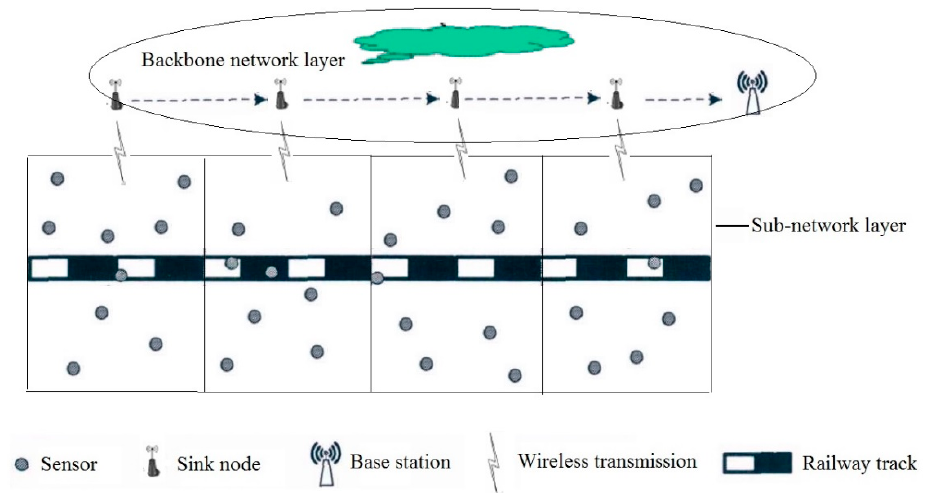
Figure 1. Architecture of double-layer wireless sensor network for railway status monitoring system.